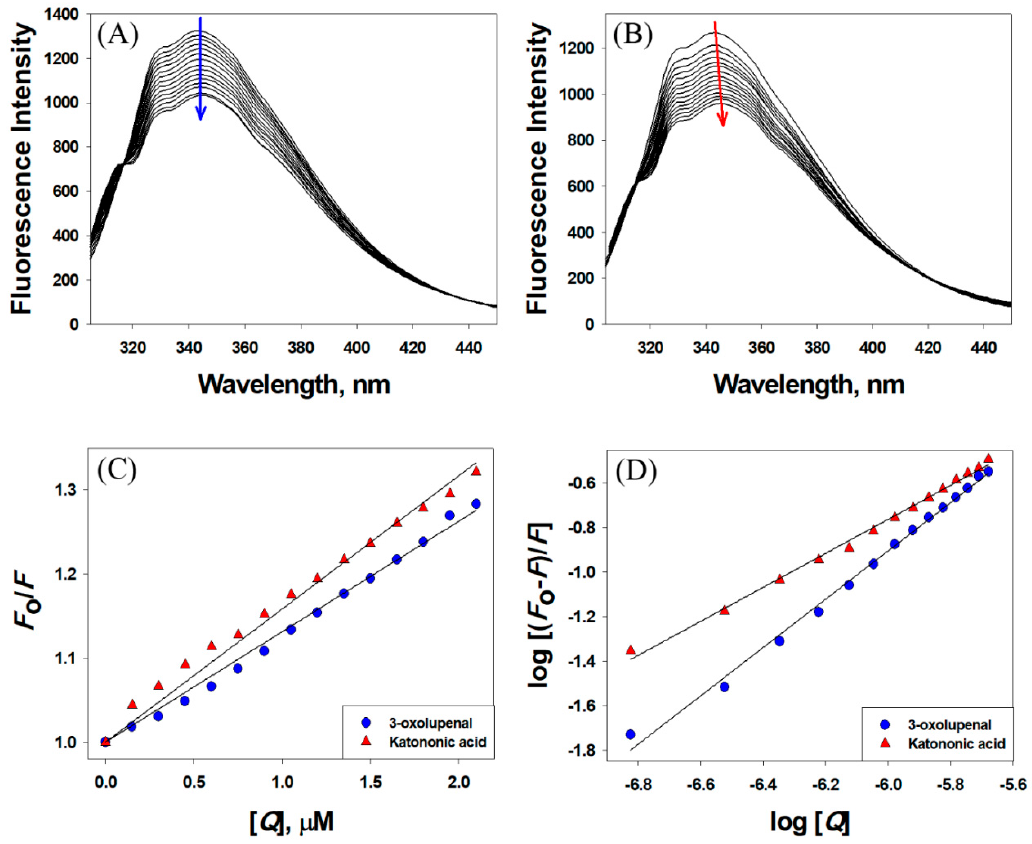
Figure 4. Interaction of α -amylase with 3-oxolupenal and katononic acid. Quenching in the fluorescence intensity of α -amylase in the presence of ( A ) 3-oxolupenal and ( B ) katononic acid. The binding parameters were deduced from ( C ) Stern–Volmer and ( D ) modified Stern–Volmer plots. Table 3. Binding parameters of α -amylase and α -glucosidase with 3-oxolupenal and katononic acid.